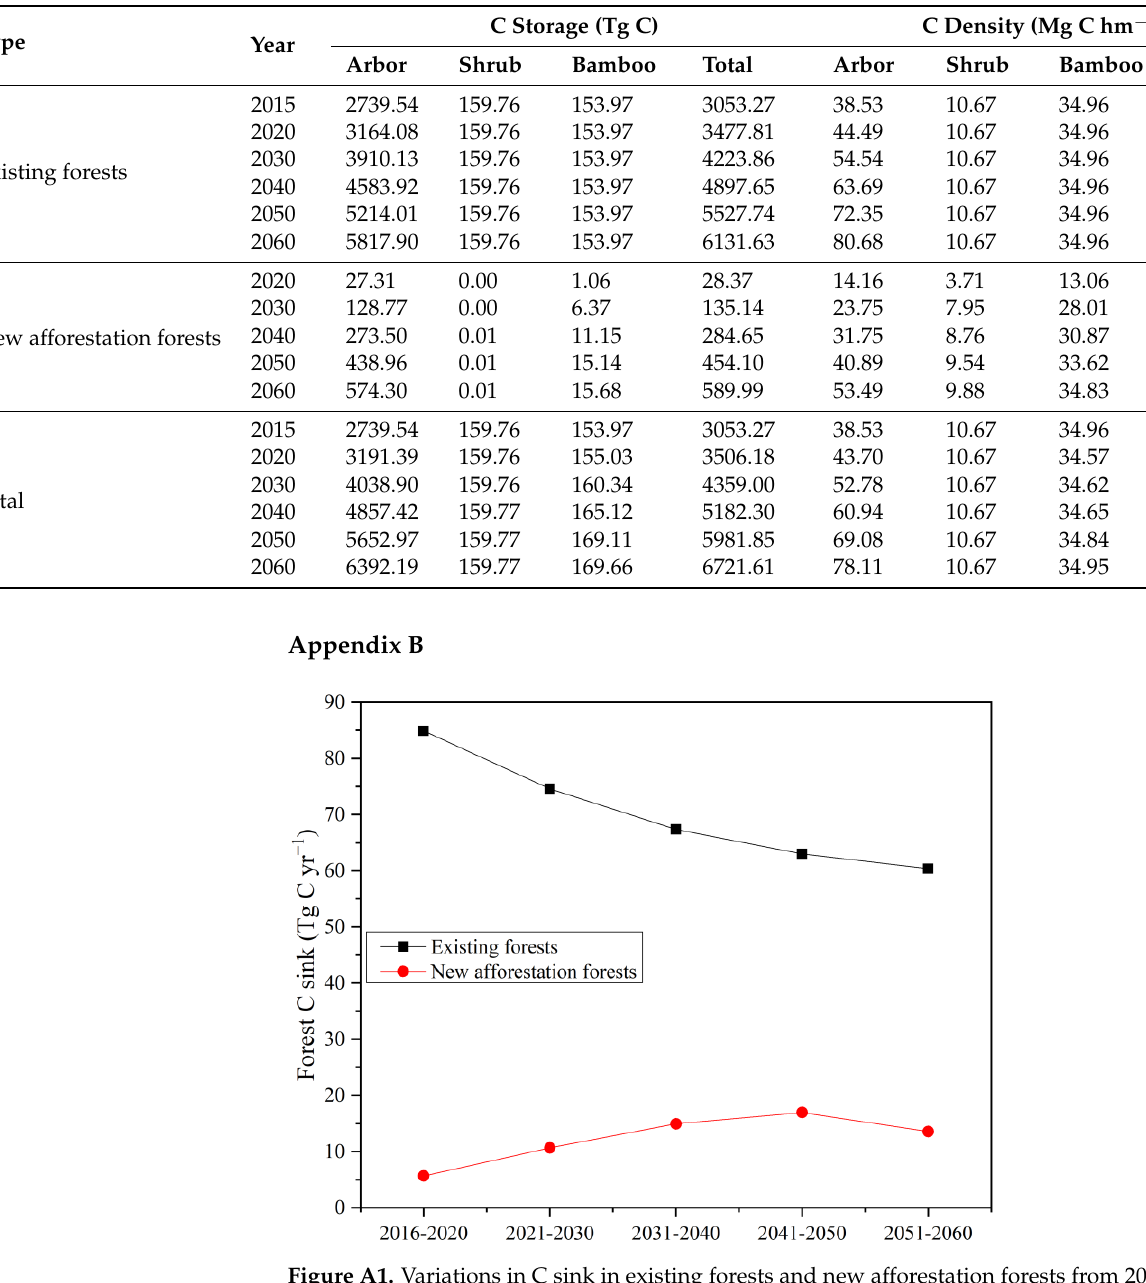
Table A8. Variations in C storage and C density of existing forests and new afforestation forests from 2015 to 2060 in the YREB.